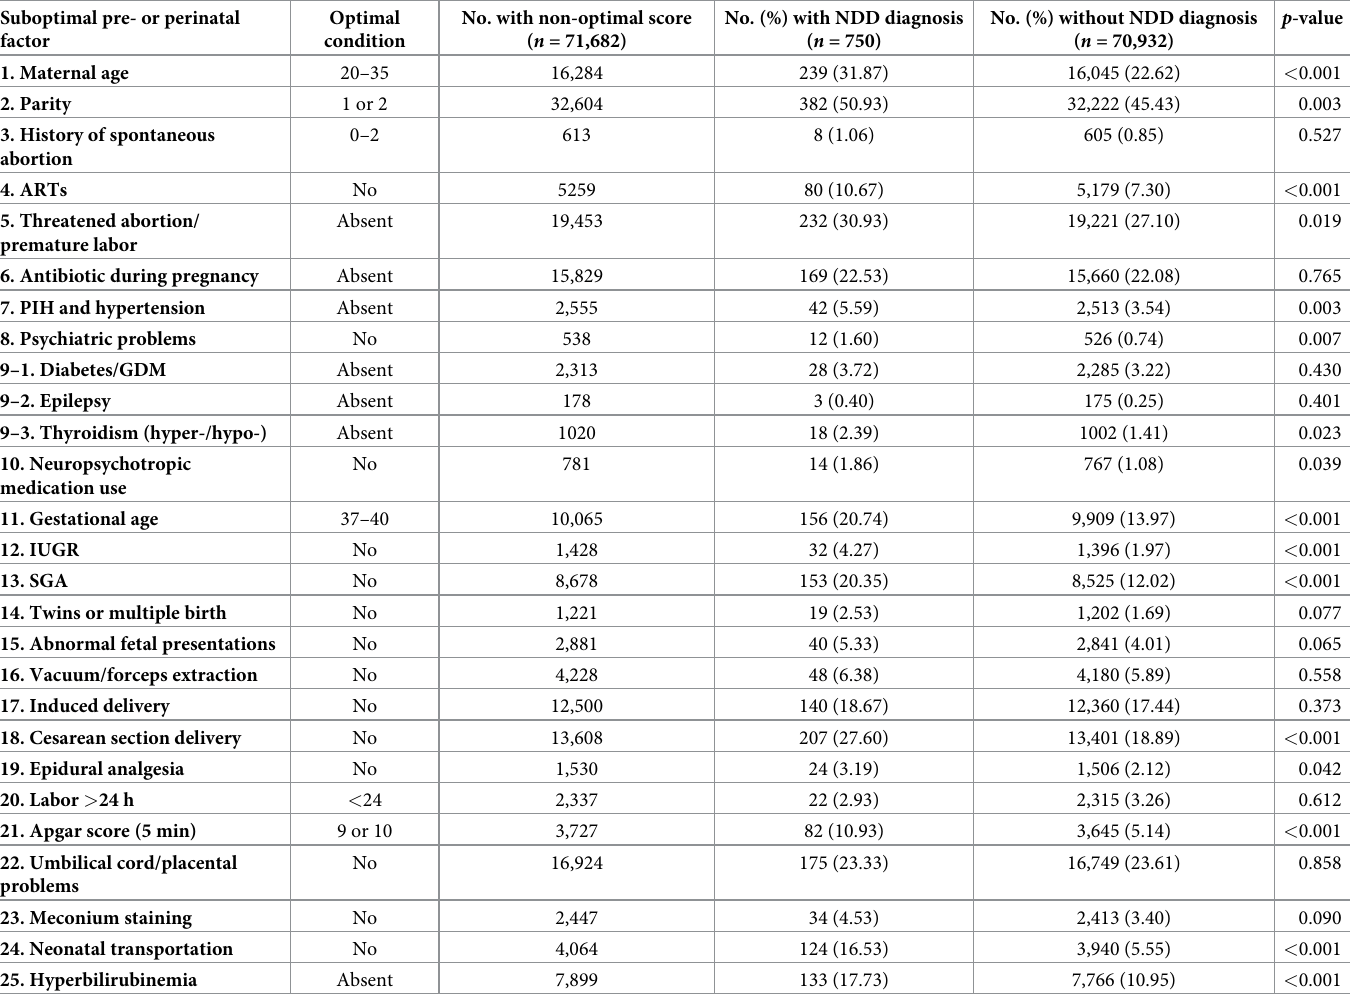
Table 3. Prevalence of pre- or perinatal factors in participants with and without a neurodevelopmental disorder diagnosis. Suboptimal pre- or perinatal Optimal factor